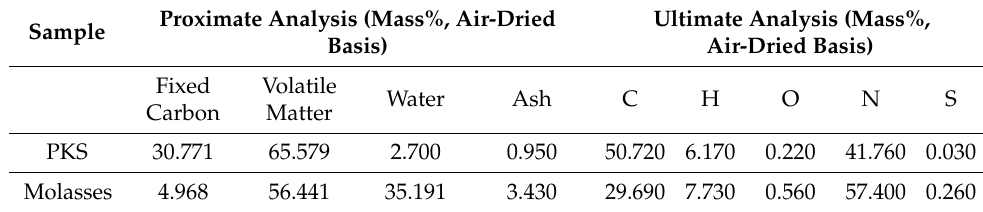
Table 2. Properties of the biomass and molasses.